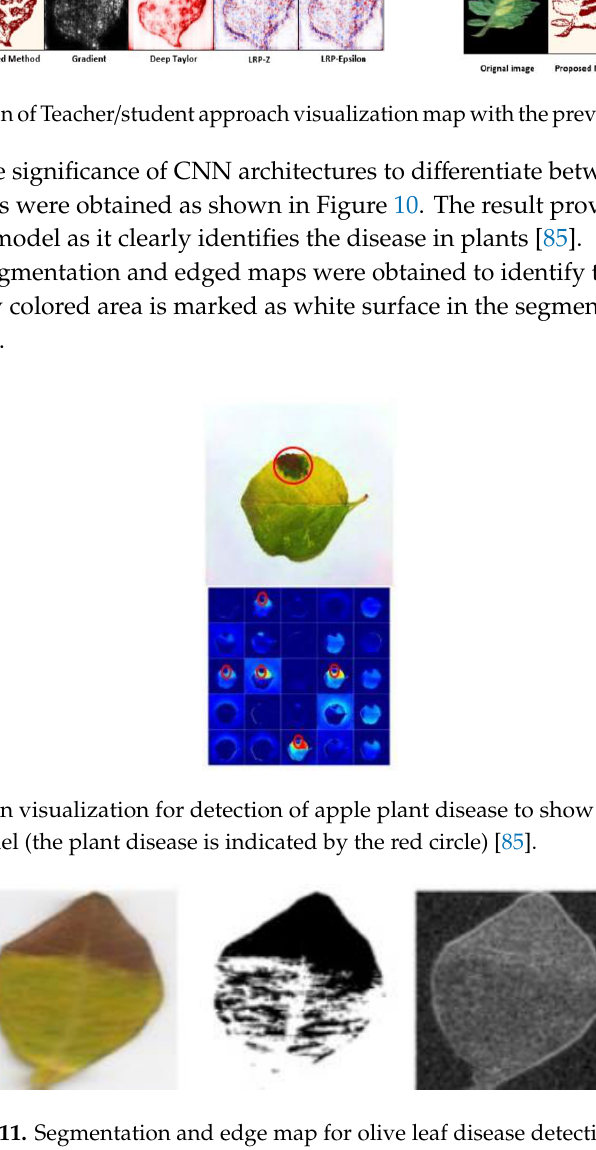
Figure 11. Segmentation and edge map for olive leaf disease detection [65] .